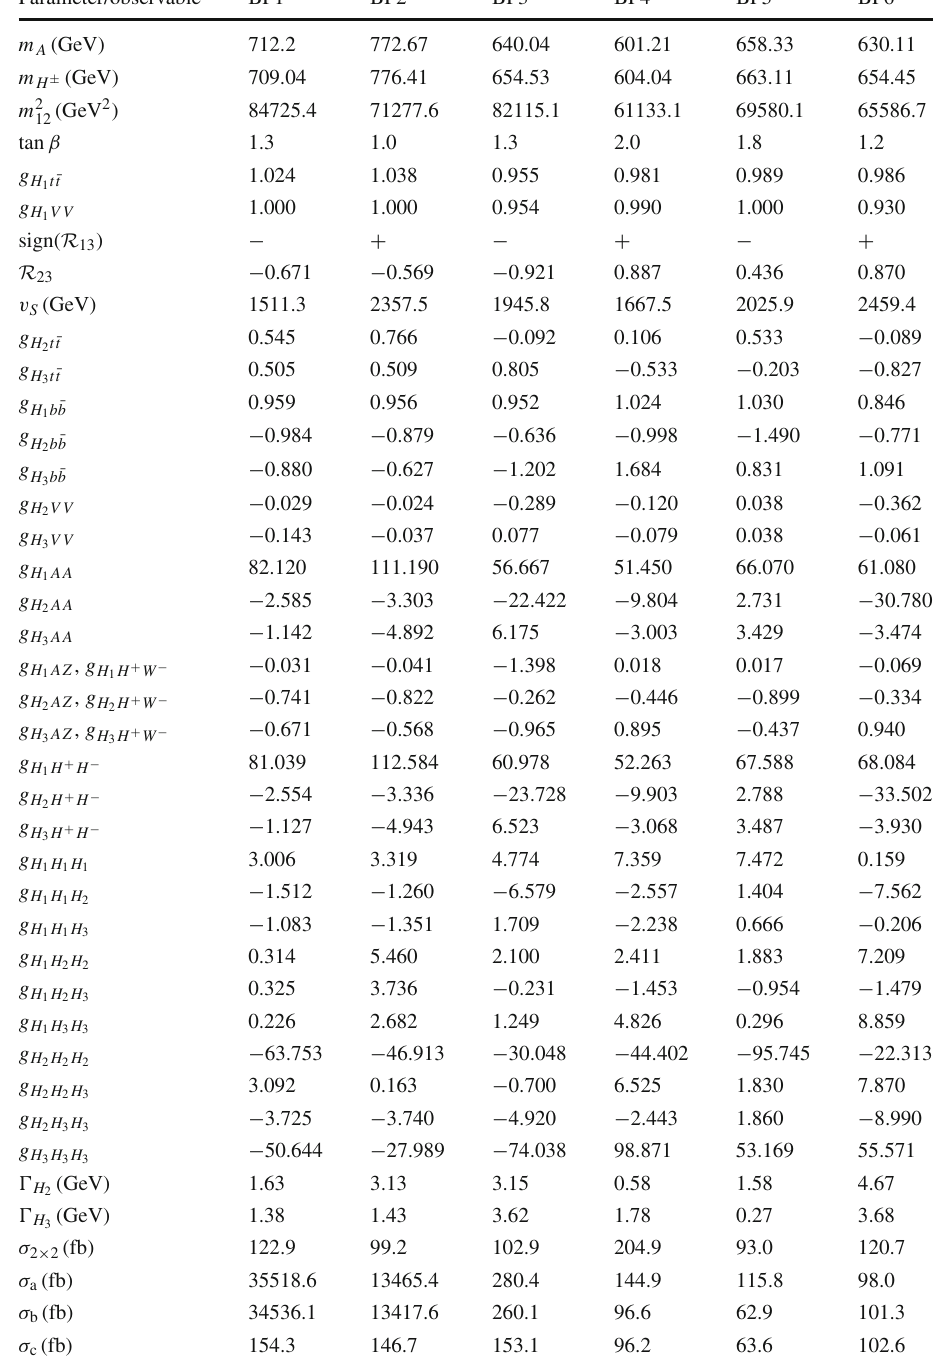
Table 2 Values of the input parameters, couplings and widths of the Higgs bosons, together with the cross sections corresponding to the six selected BPs of the